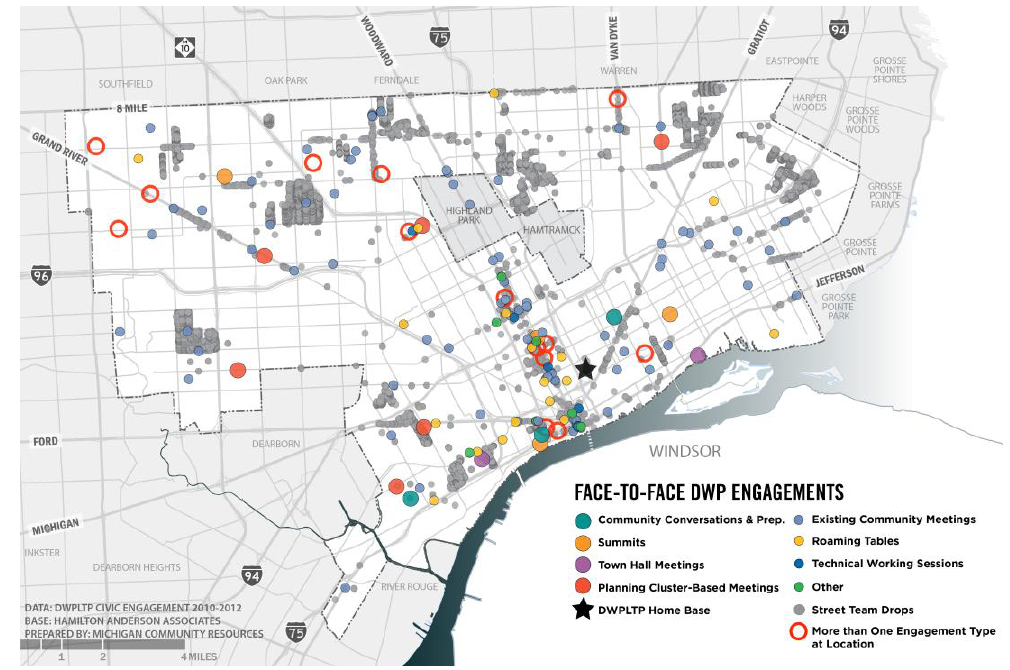
Figure 3. Map of all face-to-face civic engagement activities executed by the Detroit Works Project Civic Engagement